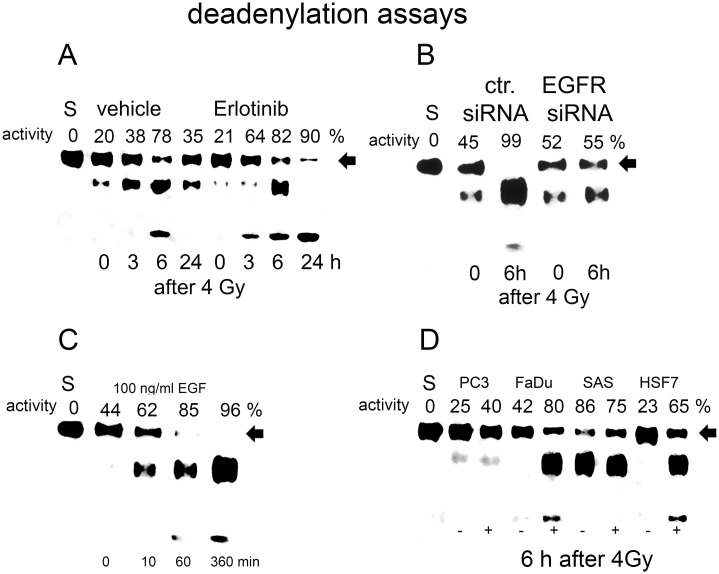
Quantification of cNOT1 adenylase activity after cNOT1 protein-IP.A: Activity was quantified after irradiation and erlotinib treatment. Activity inversely correlates with the residual amount of intact Cy3-labelled rec. mRNA substrate. Intact rec. mRNA (labelled with arrow) was quantified using LICOR gel quantification. Deadenylase activity was calculated from the amount of residual rec. mRNA compared to the amount of rec. mRNA used. S represents native rec. mRNA (0% activity). Data are presented as the means of 3 experiments. B: Quantification of radiation-induced cNOT1 deadenylase activity after EGFR knockdown with a specific siRNA. C: Quantification of cNOT1 deadenylase activity after EGF treatment. D: Quantification of cNOT1 deadenylase activity in different cell strains and lines 6 hours after irradiation.